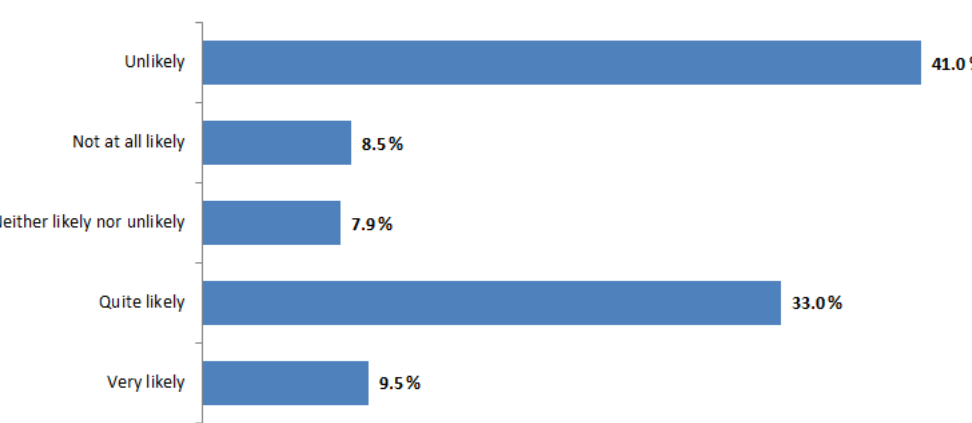
Figure 3. Perception of tsunami occurrence in the Mediterranean area.